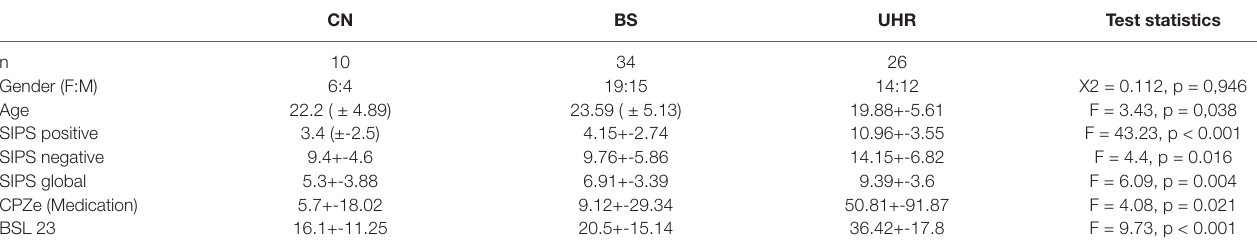
TABle 1 | Demographic and clinical